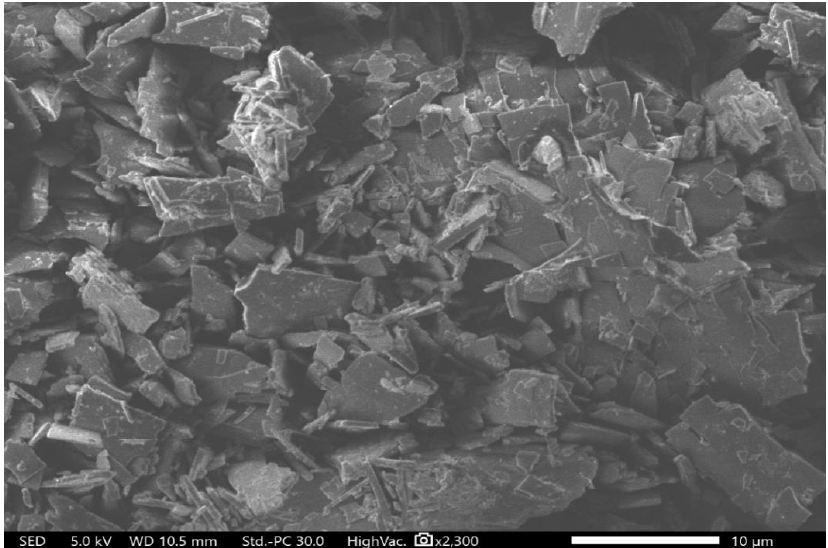
Figure 5. Scanning electron microscopy (SEM) image of halicin crystal showing the drug crystal structure.